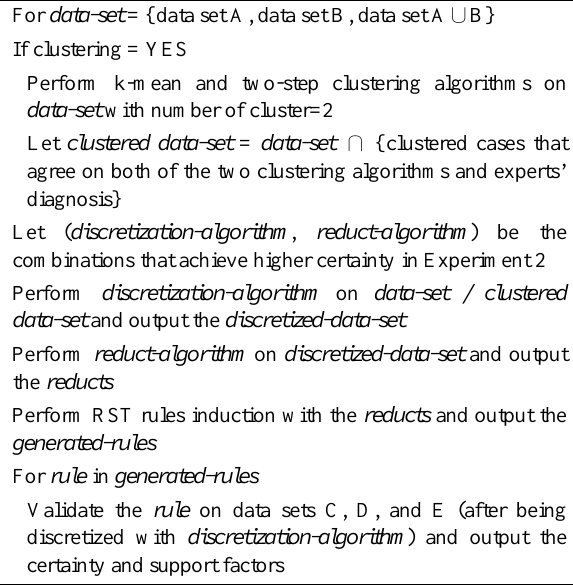
Table 4. Procedure of Experiment